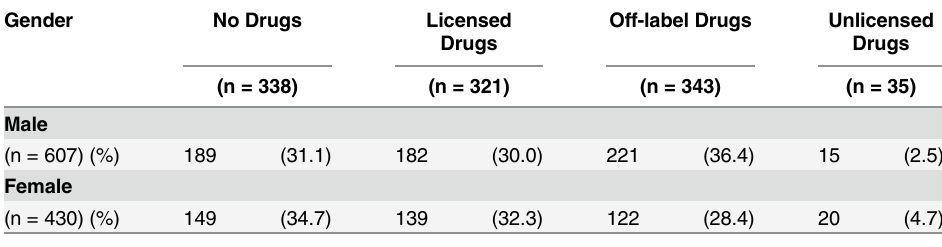
Table 1. Gender distribution of the number of patients prescribed no drugs, licensed drugs and off- label or unlicensed drugs.